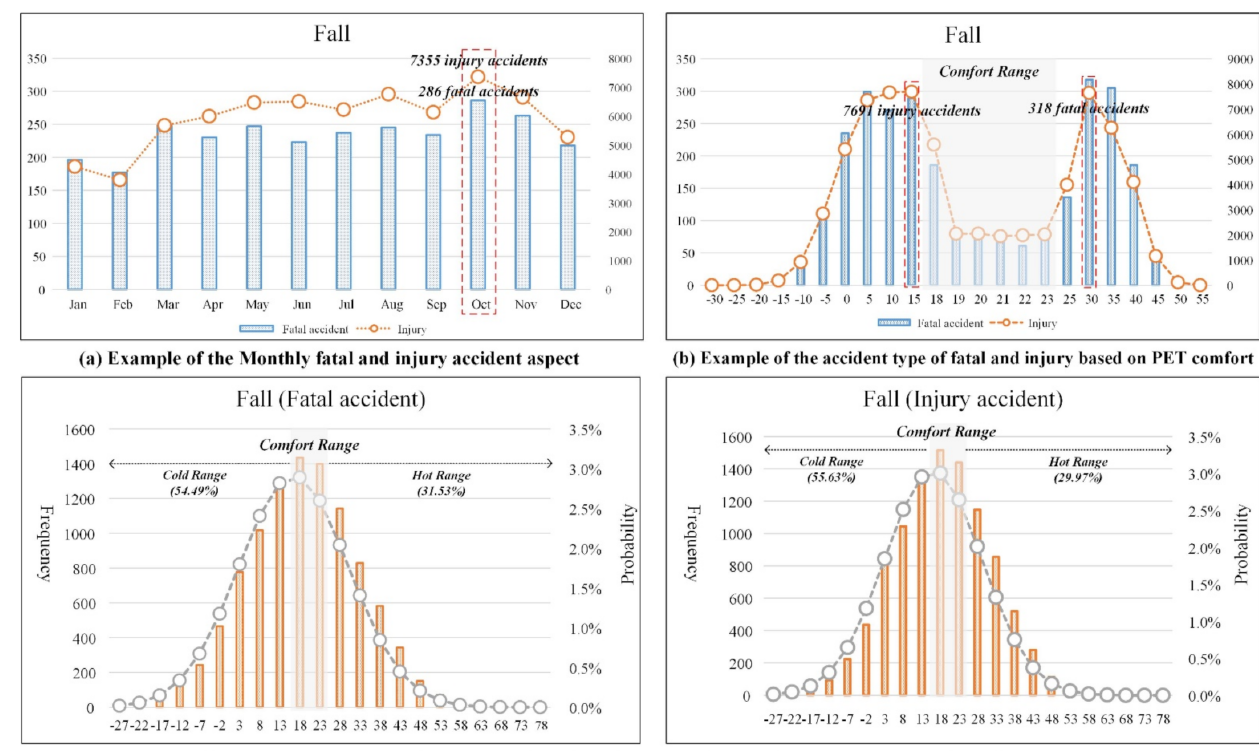
Figure 4. Examples of injury and fatal accidents in terms of thermal